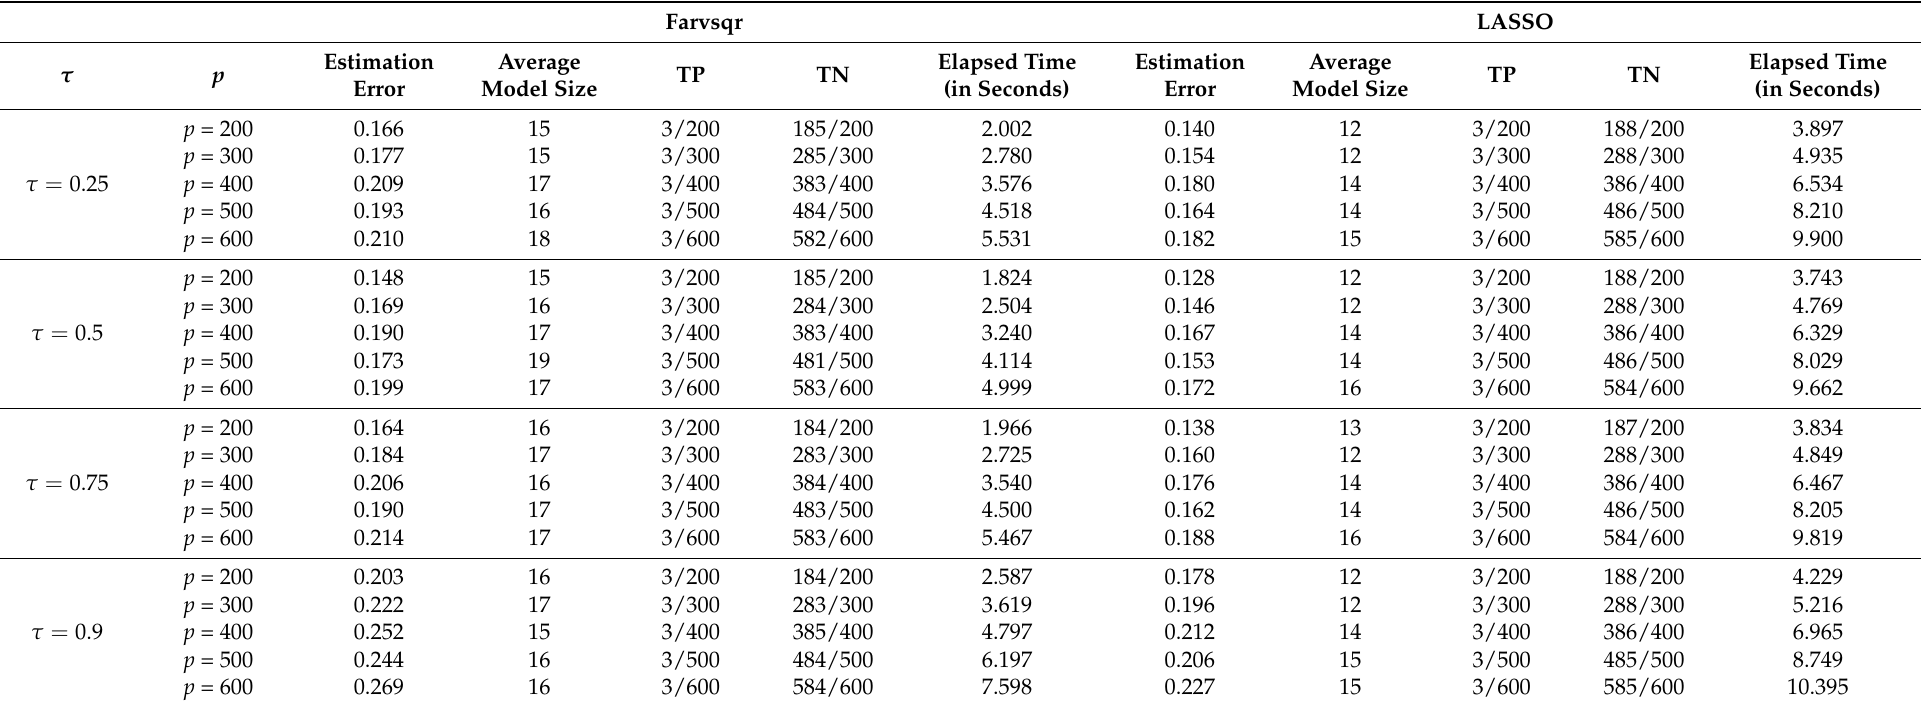
Table 10. The comparison for n = 1000, N ( 0,1 ) with the equal correlation. Farvsqr